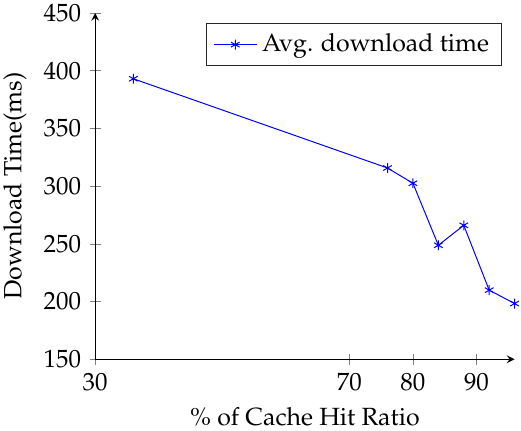
Figure 12. Average download time of Con1 vs cache hit ratio at router R4.